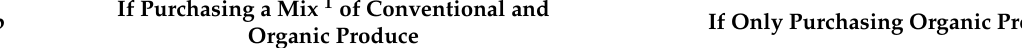
Table 2. Cost of meeting dietary guidelines recommended the number of fruit/vegetable